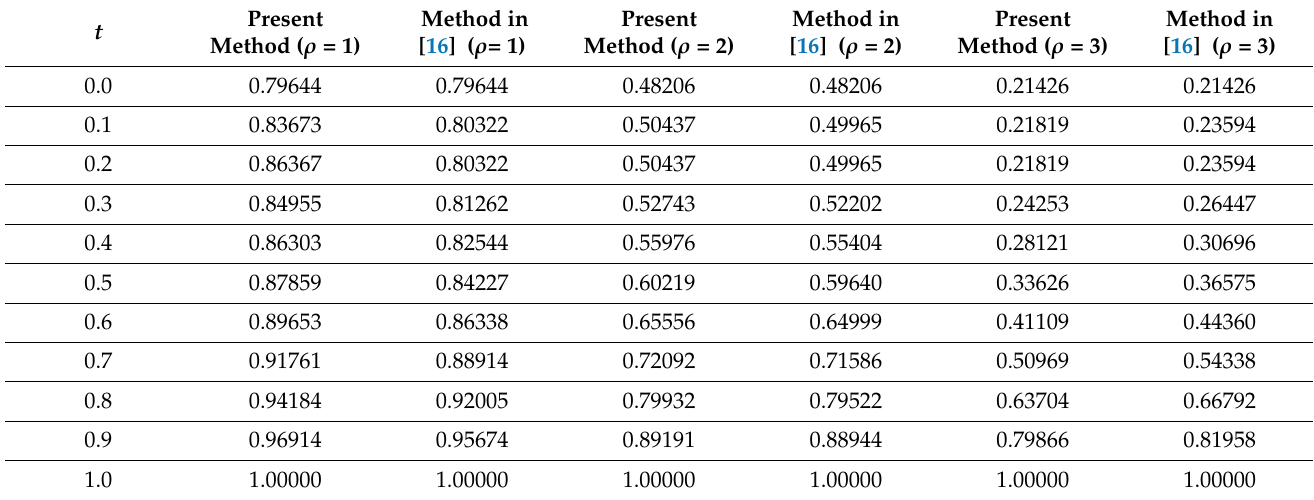
Table 5. Comparison of the results with different choices of the parameter ρ